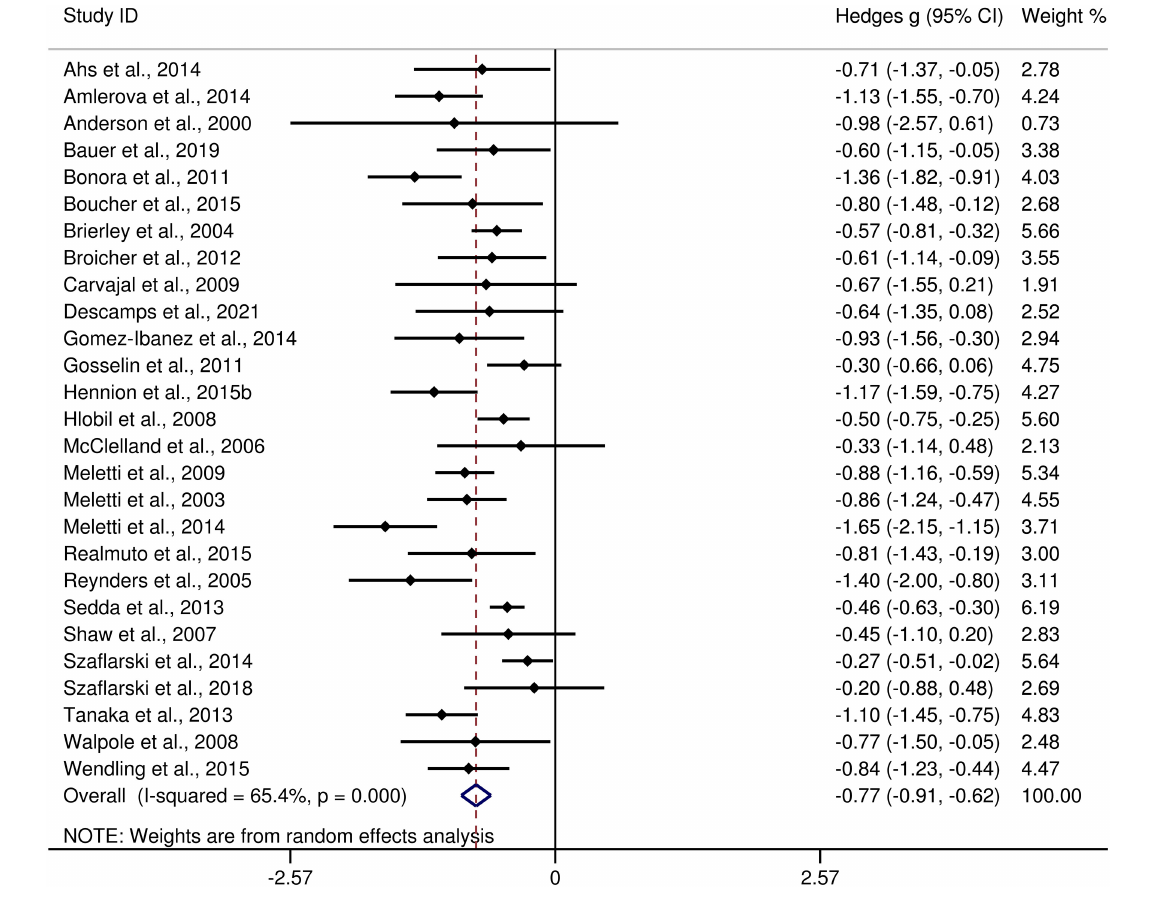
(25) and Edwards et al. (27) ( g = − 0.87, k = 16 and g = − 0.99, k = 14, respectively), which indicate a large-sized